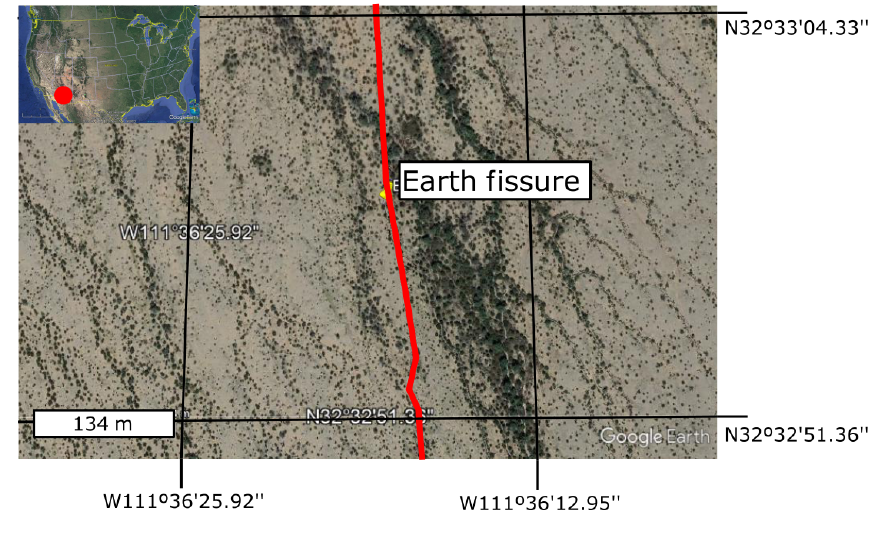
Figure 1. Location of the fissure. Source: © Google Earth.